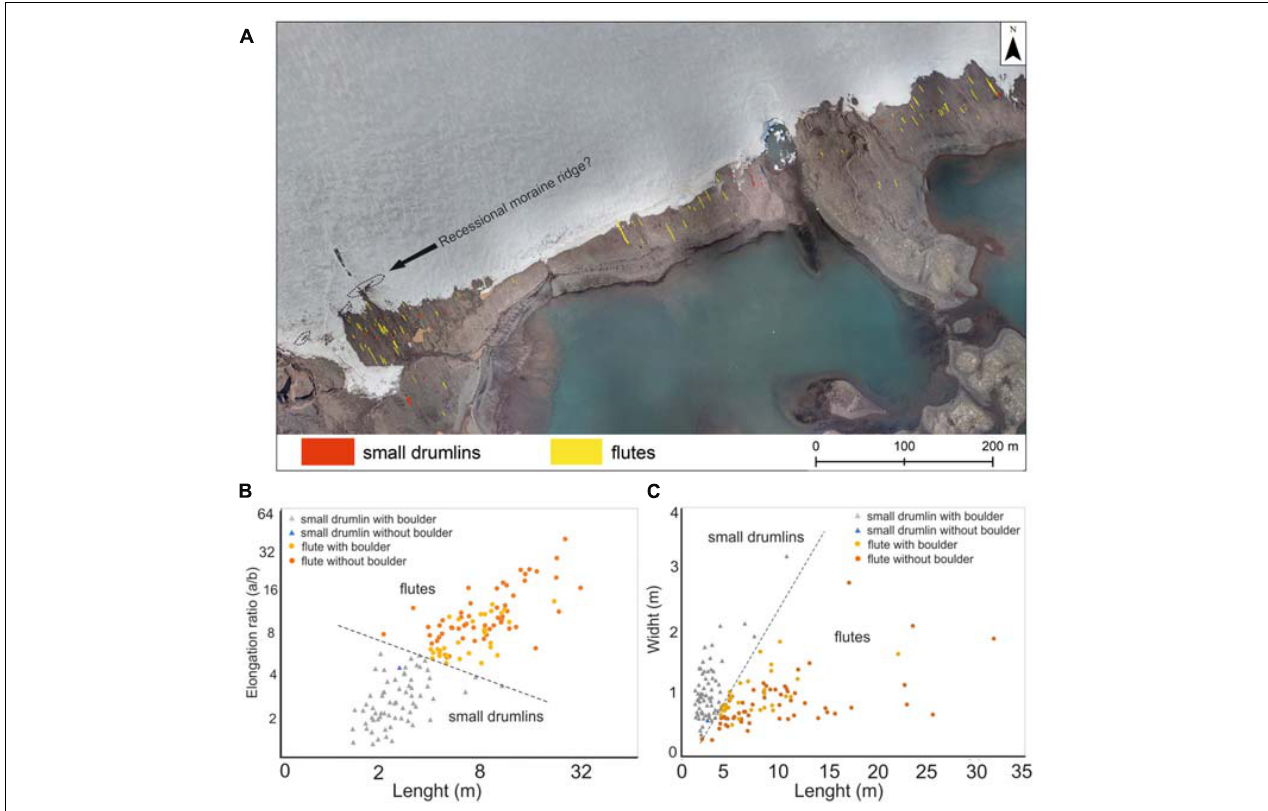
FIGURE 4 | Division between small drumlins and flutes in the Windy Glacier foreland based on their morphological characteristics; (A) spatial pattern of small drumlins and flutes; (B) length-to-elongation ratio diagram; (C) length-to-width diagram.